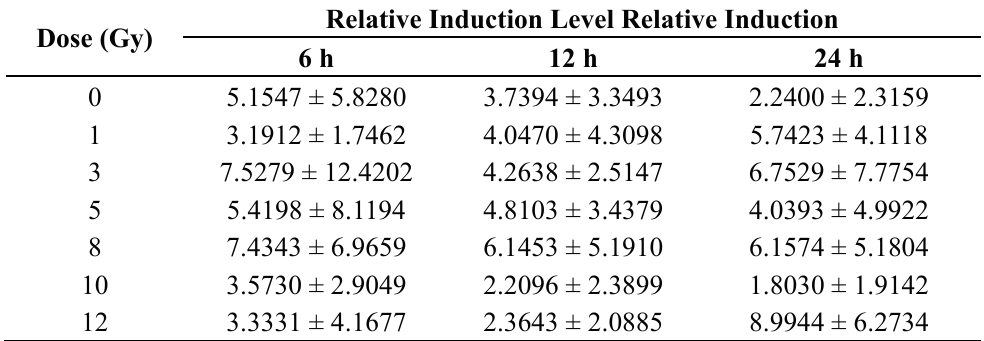
Table 3. X-ray-induced expression changes of CCL2 mRNA in human peripheral blood. Dose (Gy)